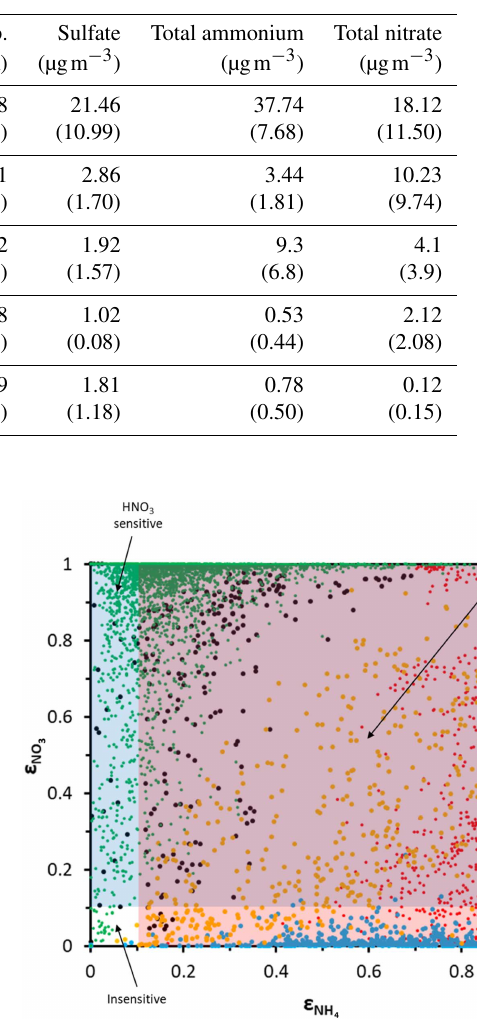
Figure 4. Aerosol partitioning fraction for total ammo- nia/ammonium and nitric acid/nitrate for the five regions examined: (a) Cabauw – CBW, (b) CalNex – CNX, (c) Tianjin – TJN, (d) SOAS – SAS, and (e) E United States